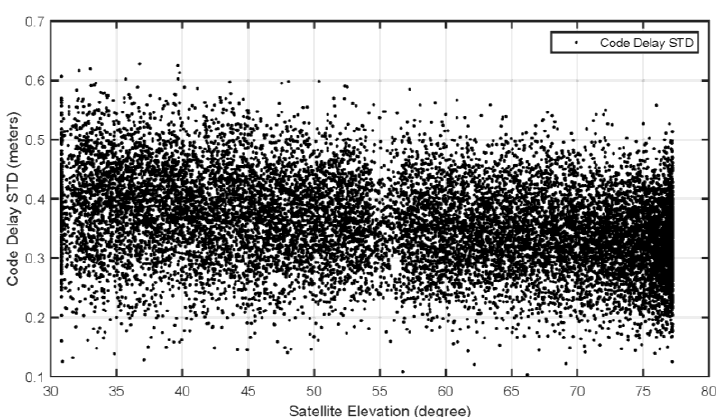
Figure 7. Satellite elevation distribution of B2a PRN 37 satellite code signal path differences STD.